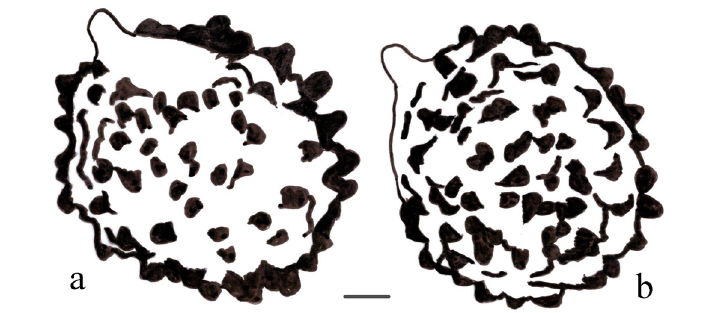
Fig. 6. Line drawings of basidiospores. a . Russula purpureorosea Y.Song sp. nov., holotype (GDGM75331). b . Russula fusiformata Y.Song sp. nov., holotype (GDGM 75333). Scale bar = 1